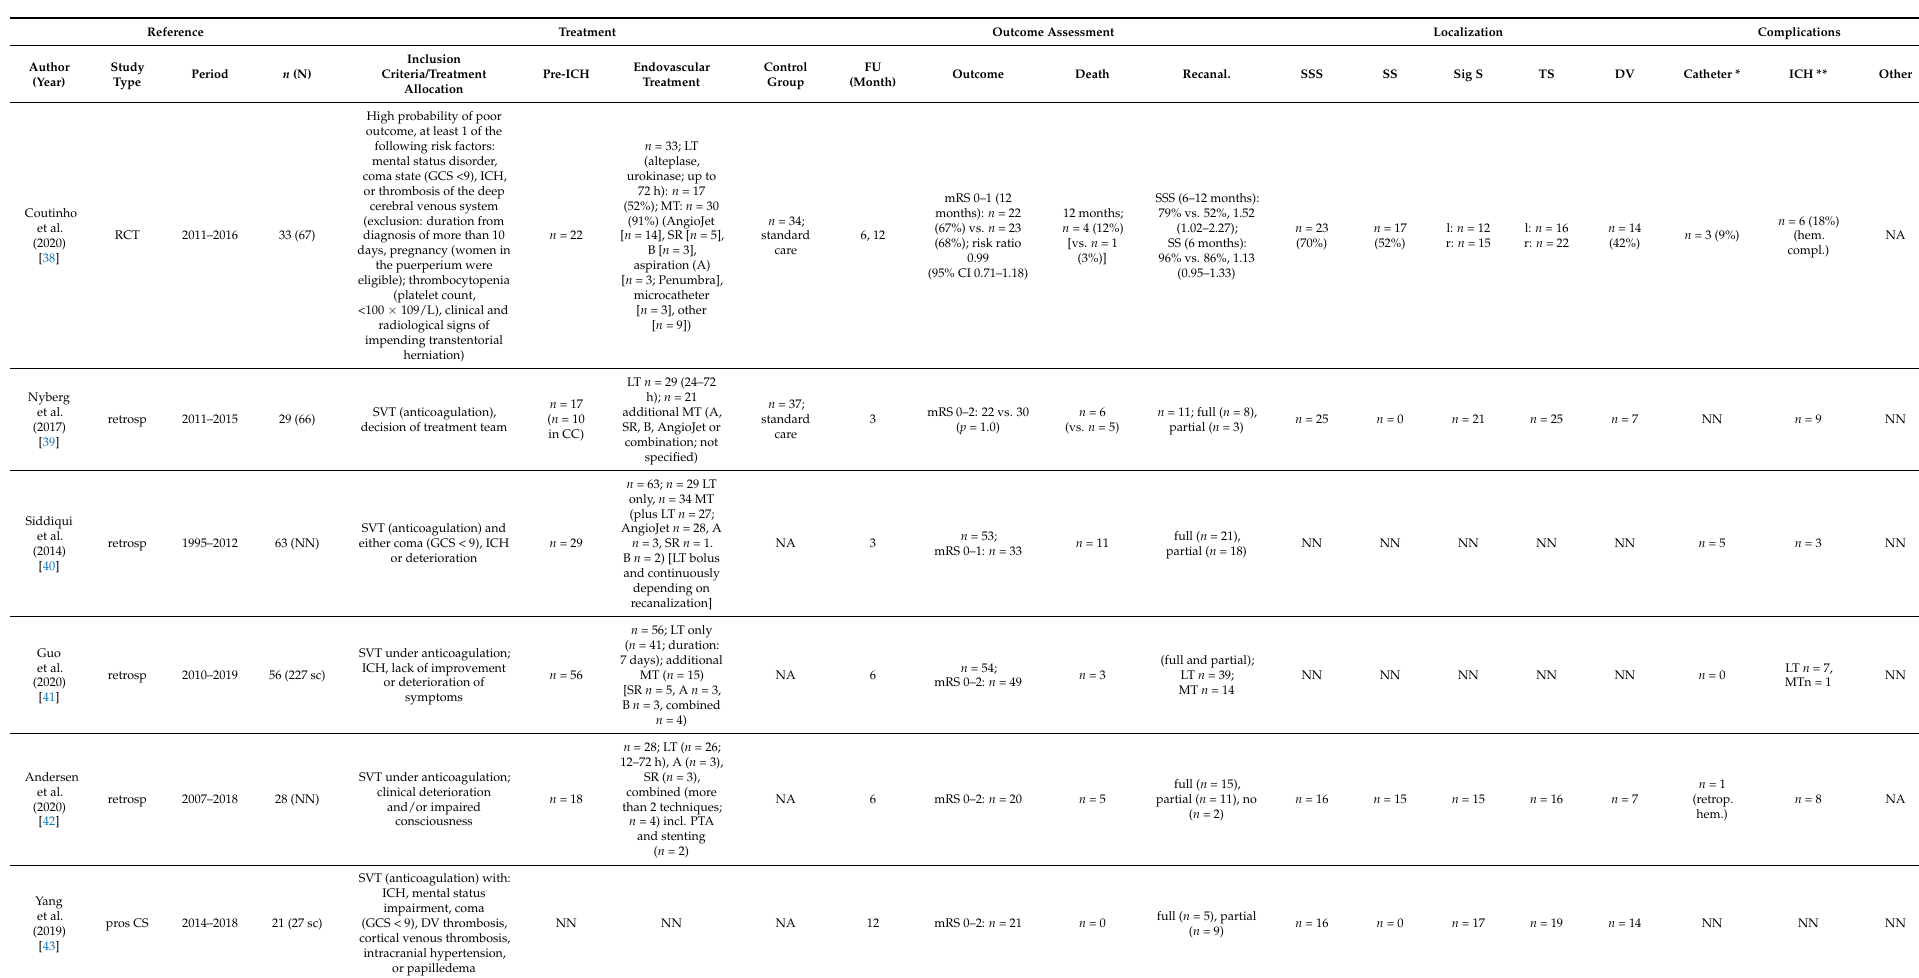
Table 1. Summary of the 21 records included in this systematic